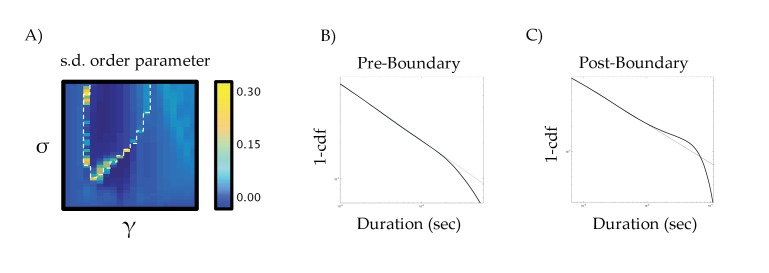
Standard deviation of the order parameter across the parameter space.(a) standard deviation of order parameter across the parameter space; (b) fluctuation scaling pre-boundary (σ = 0.375 and γ = 0.50); and (c) post-boundary (σ = 0.50 and γ = 0.575) – the thin blue line denotes a Pareto (i.e., power law) scaling effect.